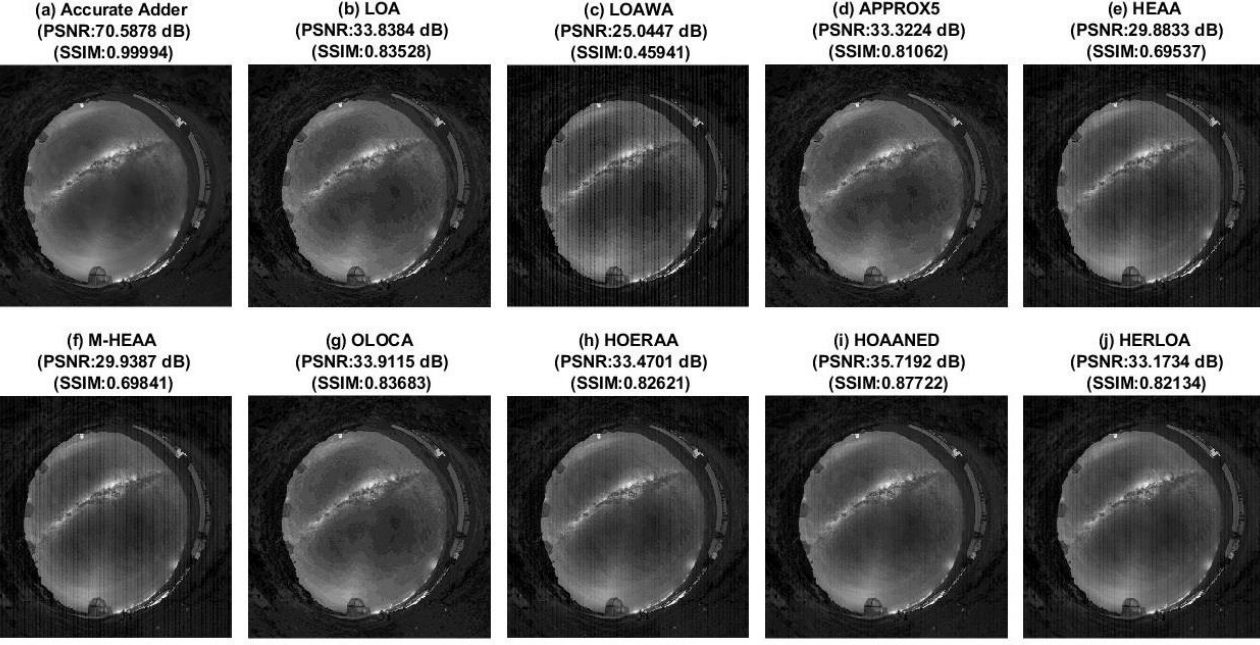
Figure 5. La Silla image compressed using accurate adder and different approximate adders, with the approximate adders having a 12-bit inexact part.